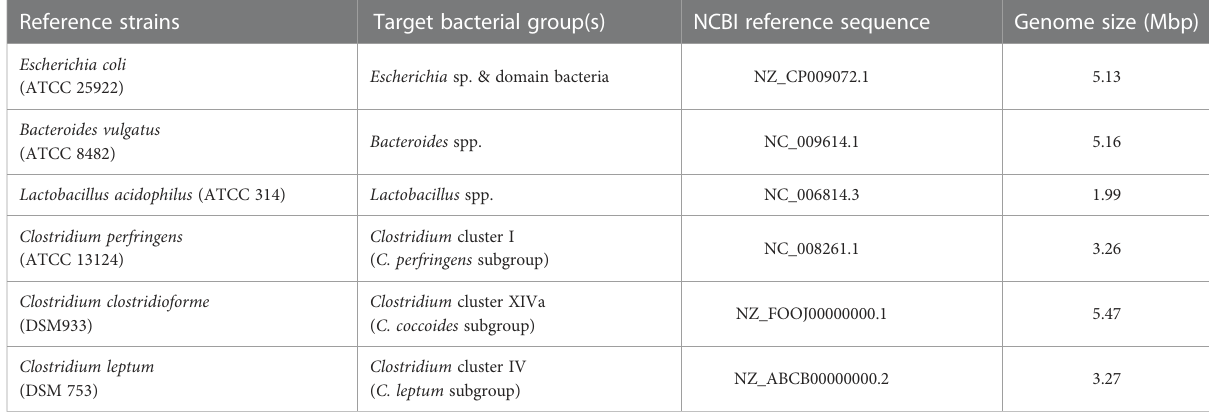
TABLE 2 Reference strains and genome sizes.